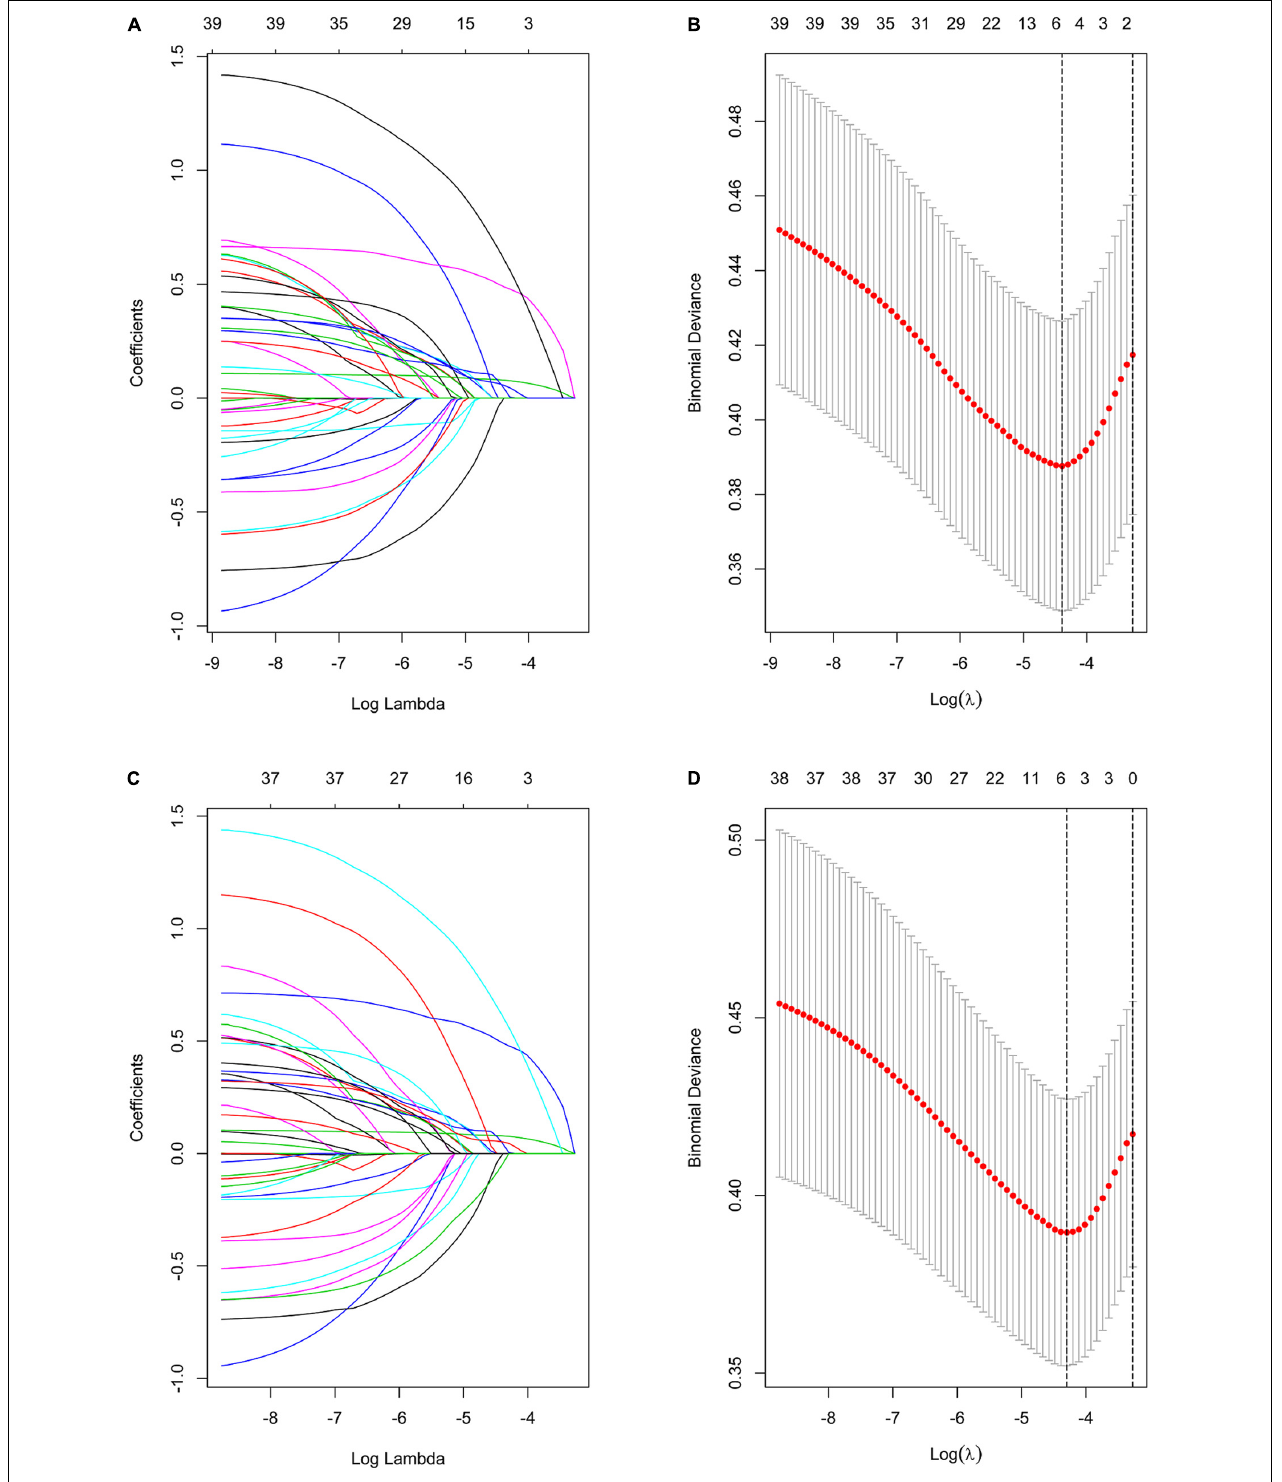
FIGURE 3 | Variable selection using the LASSO binary logistic regression model. (A) Profiles of the LASSO coefficients for the 36 candidate variables. (B) Optimal penalization coefficient ( λ ) selection in the LASSO model used 10-fold cross-validation via minimum criteria. (C) Profiles of the LASSO coefficients for the 37 (Plus GNRI) candidate variables. (D) Optimal penalization coefficient ( λ ) selection in the LASSO model used 10-fold cross-validation via minimum criteria. Note: the left vertical line represents the minimum error, and the right vertical line represents the one standard error of the minimum criteria (1-SE criterion).